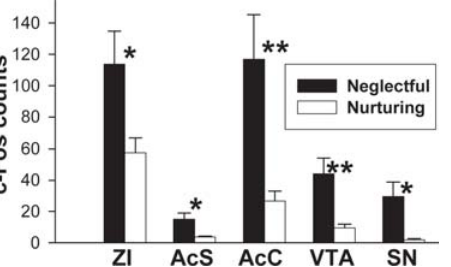
Figure 5. Altered c-Fos expression with maternal neglect. Heightened c-Fos expression in dopamine releasing and responding regions in neglectful (N=8) relative to nurturing (N= 9) mice. Significantly higher levels of c-Fos are found in ZI, VTA, and substantia nigra (SN), all of which are involved in dopamine production. Both nucleus accumbens shell (AcS) and core (AcC), which respond to dopamine signaling, also show increased c-Fos in neglectful mice. Other regions examined for c-Fos are shown in Table 1. Bars represent means 6 SE. * =p , 0.05; ** =p , 0.01.